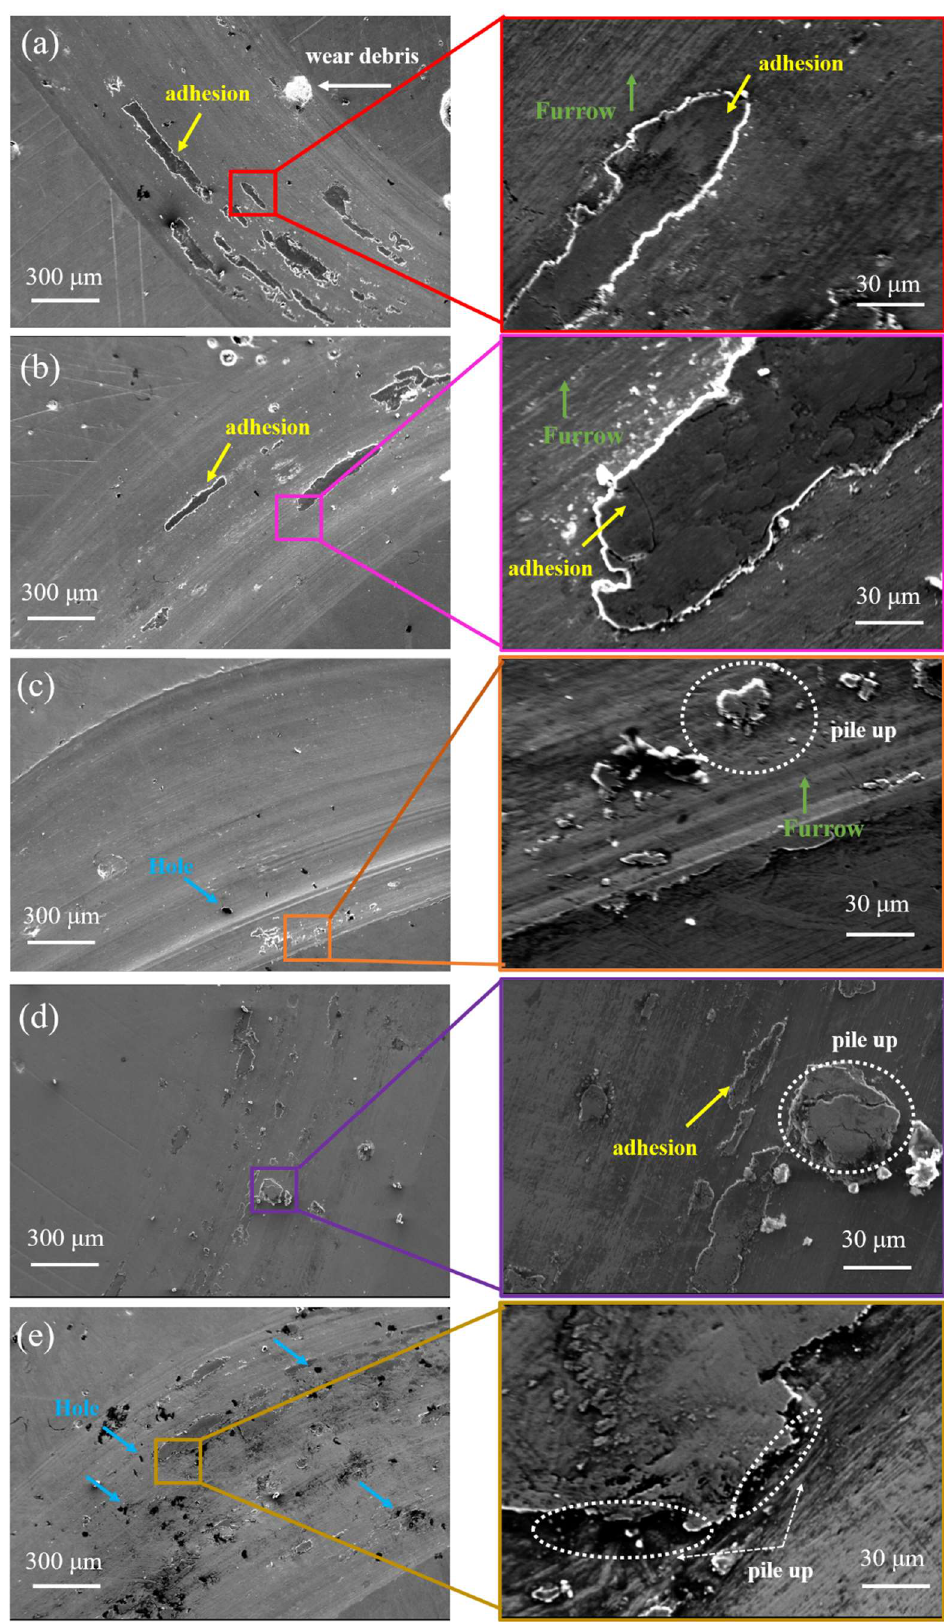
Figure 10. SEM local images of the wear surface of the CoCrFeMnNiTi x high-entropy alloy coatings: